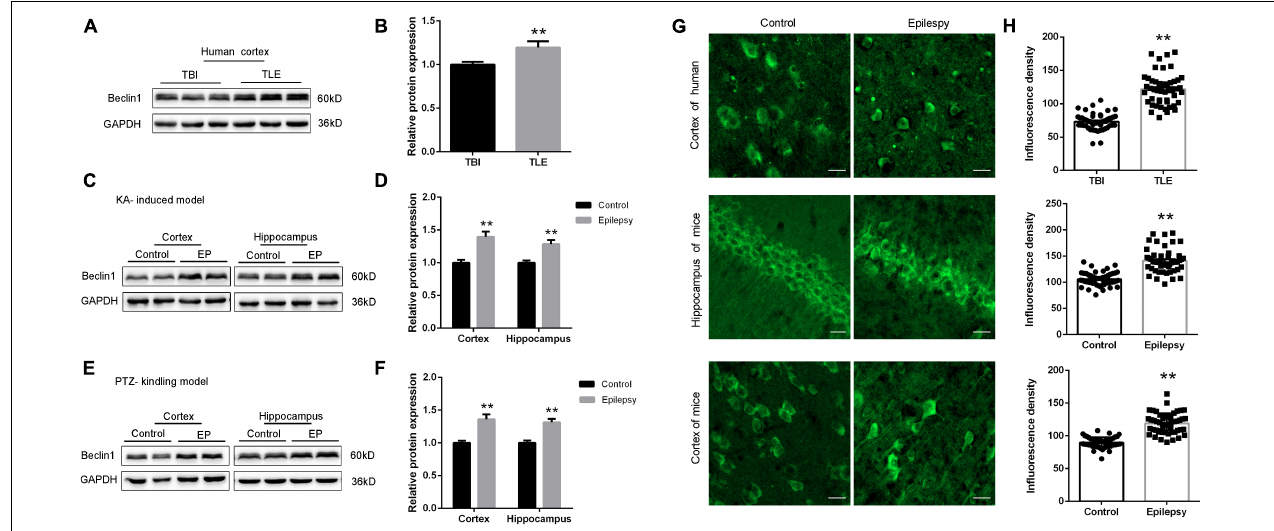
FIGURE 1 | Beclin1 expression was increased in patients with TLE and epileptic mice. (A,B) Beclin1 protein levels in patients with traumatic brain injury (TBI) and patients with epilepsy ( n = 8 patients per group). (C,D) The Beclin1 protein levels in cortex and hippocampus from wild-type (WT) mice and kainic acid (KA)-treated mice ( n = 8 mice per group). (E,F) The Beclin1 protein levels in cortex and hippocampus from WT mice and pentylenetetrazol (PTZ)-treated mice ( n = 8 mice per group). (G,H) IF staining and semi-quantitative analysis of Beclin1 puncta fluorescence intensity in cortical and hippocampal tissues from patients with temporal lobe epilepsy (TLE) and two epileptic mouse models ( n = 50 samples per group). Scale bars: 50 µ m. Data are presented as the means ± SEM, ** p < 0.01. Student’s t -tests were performed.